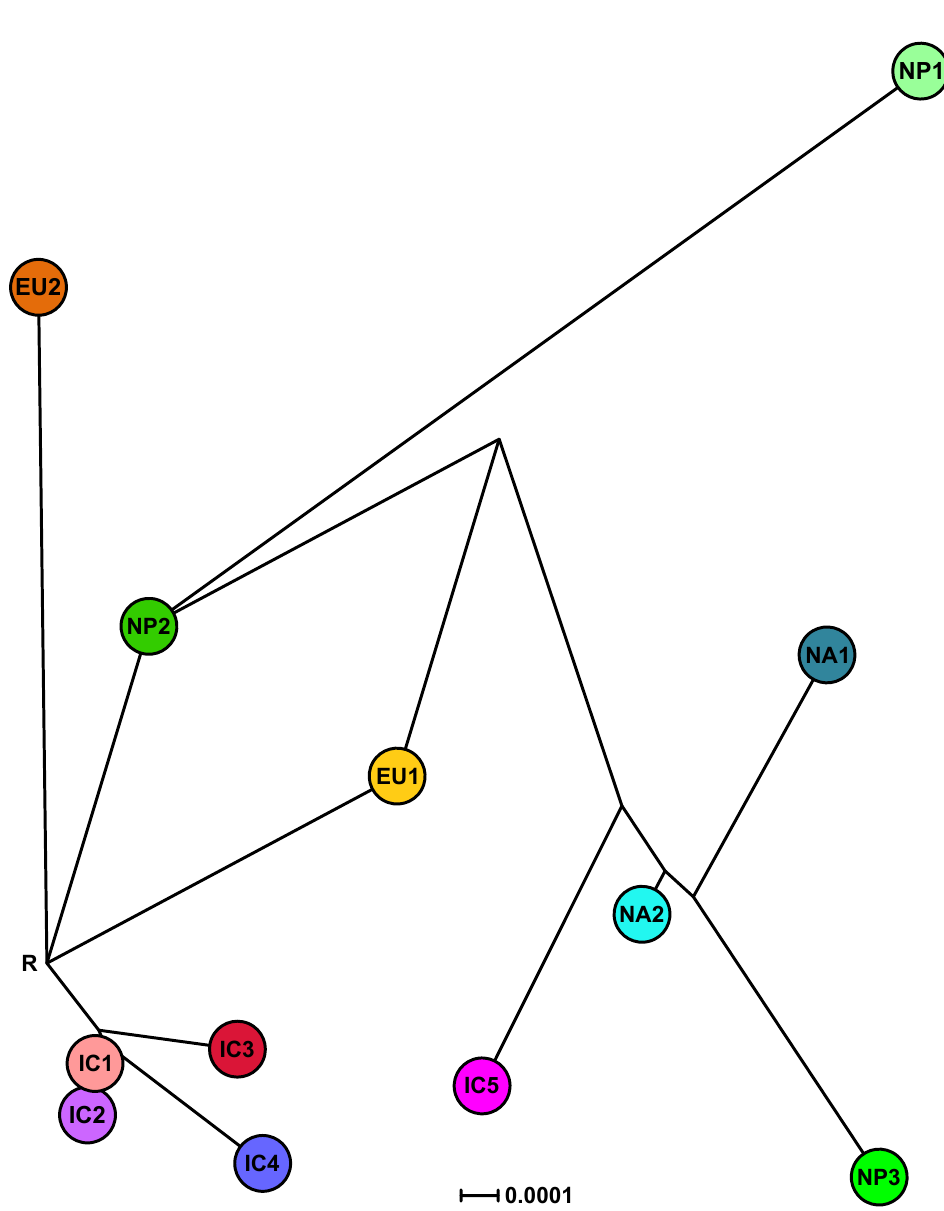
Figure 10. Split decomposition network (SDN) for the five Indochinese lineages (IC1-5), the three Japanese lineages (NP1-3) and the four known lineages (EU1, EU2, NA1 and NA2) of Phytophthora ramorum based on a seven-locus nuclear ( Avh120 , Avh121 , btub , gwEuk.30.30.1, hsp90 , ITS and trp1 ) dataset. Alternative pathways are shown as parallel edges. The node with the highest number of connections and the most central position was designated as root (R). Missing intermediates represent extant unsampled genotypes, extinct ancestors or “false-positives”. The scale bar represents the split support for the